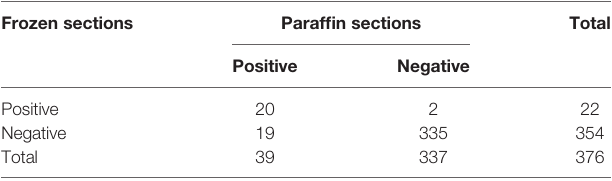
TABLE 3 | The consistency of MVI between frozen sections and paraf fi n sections. Frozen sections